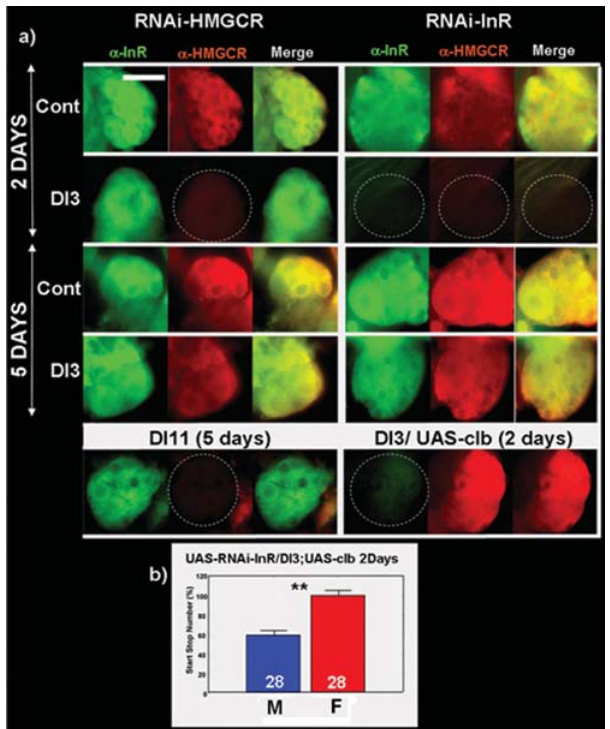
Figure 7. Insulin signaling pathway controls the sexual dimorphism via HMGCR. a) Immunostaining using primary antibodies against the InR and/or HMGCR, revealed by secondary antibodies labeled with FITC (green) or Cy3 (red) respectively. HMGCR and InR are colocalized in the same cells of the ca . Blocking the expression of the HMGCR does not influence the expression of the InR, but abolishes the sexual dimorphism. However, blocking the expression of the InR blocks the expression of the HMGCR and consequently abolishes the sexual dimorphism. This suggests that the InR controls the expression of the HMGCR within the ca . To test this hypothesis, we directed the expression of the UAS- clb concomitantly with the UAS-RNAi-InR (DI-3/ UAS-RNAi-InR; UAS- clb ). In this case, although InR is not detectable, HMGCR is present in the ca and the start/stop number is sexually dimorphic between males and females (b). Scale bar=25 m